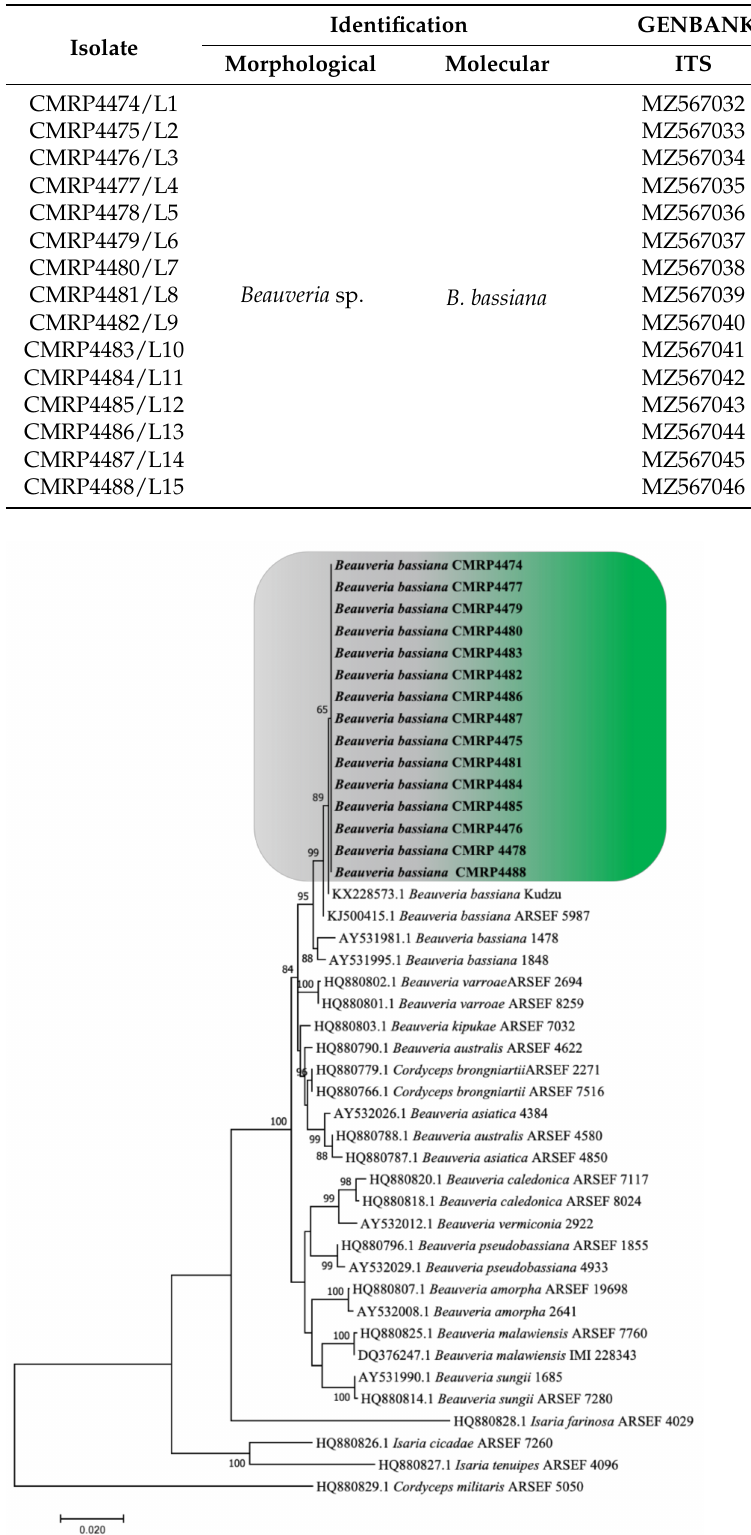
Figure 1. Maximum likelihood phylogenetic tree of the Beauveria species recovered in the MEGA 7.0 software based on the concatenated alignment of the transcribed internal spacer (ITS) and the